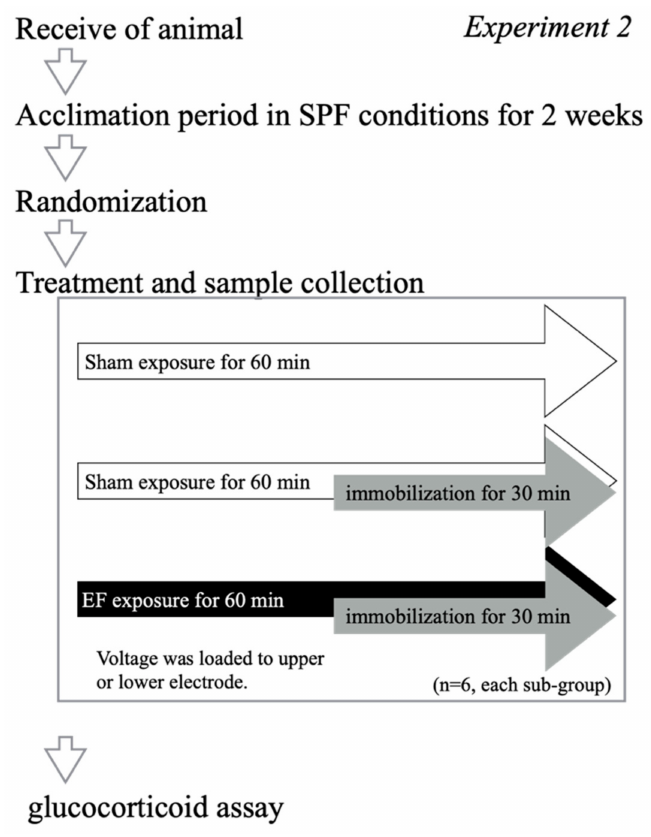
Figure 3. Experimental design to assess the effect of the polarization of the electrode on the sup- pressive effect of EF, Experiment 2. To examine the effect of the polarization of the electrode that the high voltage signal was loaded into on the suppressive effect of an EF on plasma GC in immobi- lized mice, 24 mice were divided into four groups ( n = 6, each group): control (stress ( − )/EF ( − )), immobilization-alone (stress (+)/EF ( − )), and two co-treatment groups (stress (+)/EF (+)), in which a voltage of 1 kV was applied to either the upper or lower electrode at 10